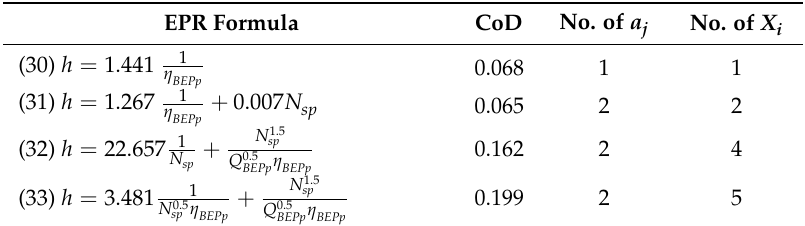
Table 15. Models returned by EPR-MOGA for